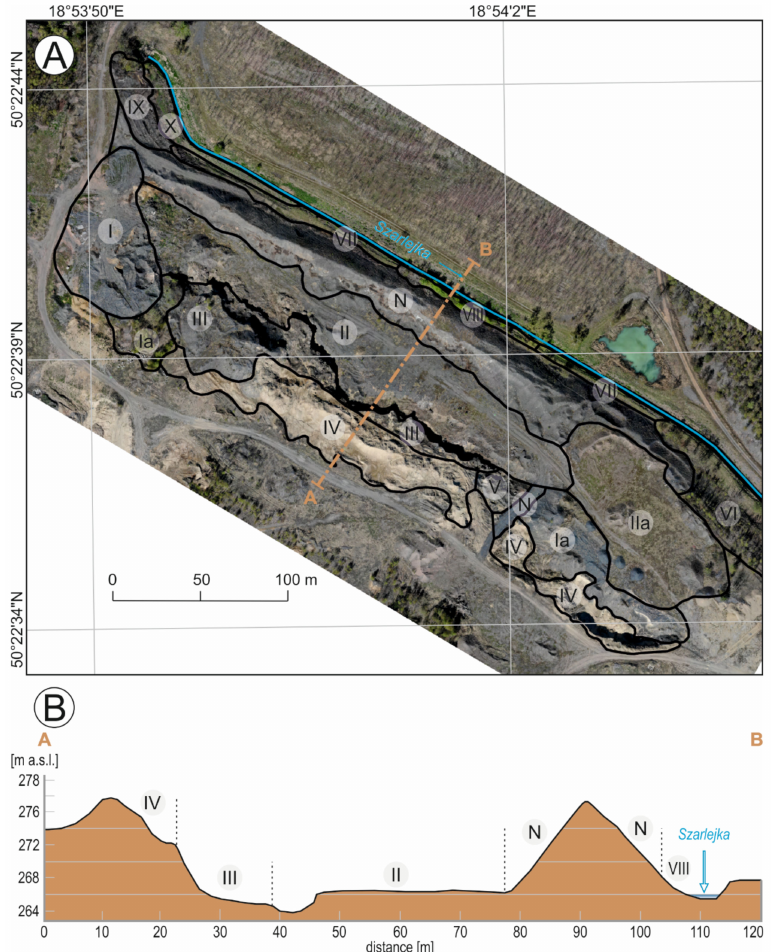
Figure 9. Vegetation map ( A ) on the orthophotomap (29 March 2019) and altitude profile ( B ) of the D-B-2 coal-waste dump: I: loose community with Eupatorium cannabinum and Solidago canadensis , Ia: dense community with Eupatorium cannabinum and Solidago canadensis , II: loose community with Calamagrostis epigejos , IIa: dense community with Calamagrostis epigejos , III: scrub with Populus tremula-Betula pendula-Salix caprea , IV: community with Deschampsia ceaspitosa , V: community with Calamagrostis epigejos and Reseda lutea , VI: stand with Pinus sylvestris and Betula pendula , VII: scrub with Urtica dioica , VIII: stand with Salix fragilis , IX: destroyed stand with Betula pendula , X: scrub with Erigeron annuus , and N—zones without plant